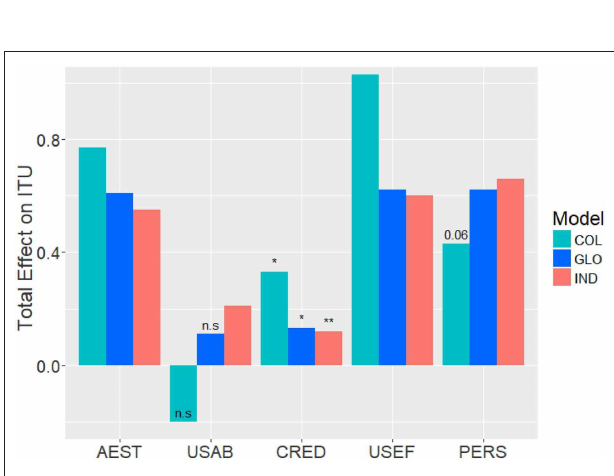
FIGURE 6 | Total Effect of perceived UX design constructs on intention to use (each construct without a label is significant at p < 0.001). AEST, Perceived Aesthetics; USAB, Perceived Usability; CRED, Perceived Credibility; USEF, Perceived Usefulness; PERS, Perceived Persuasiveness. ITU, Intention to